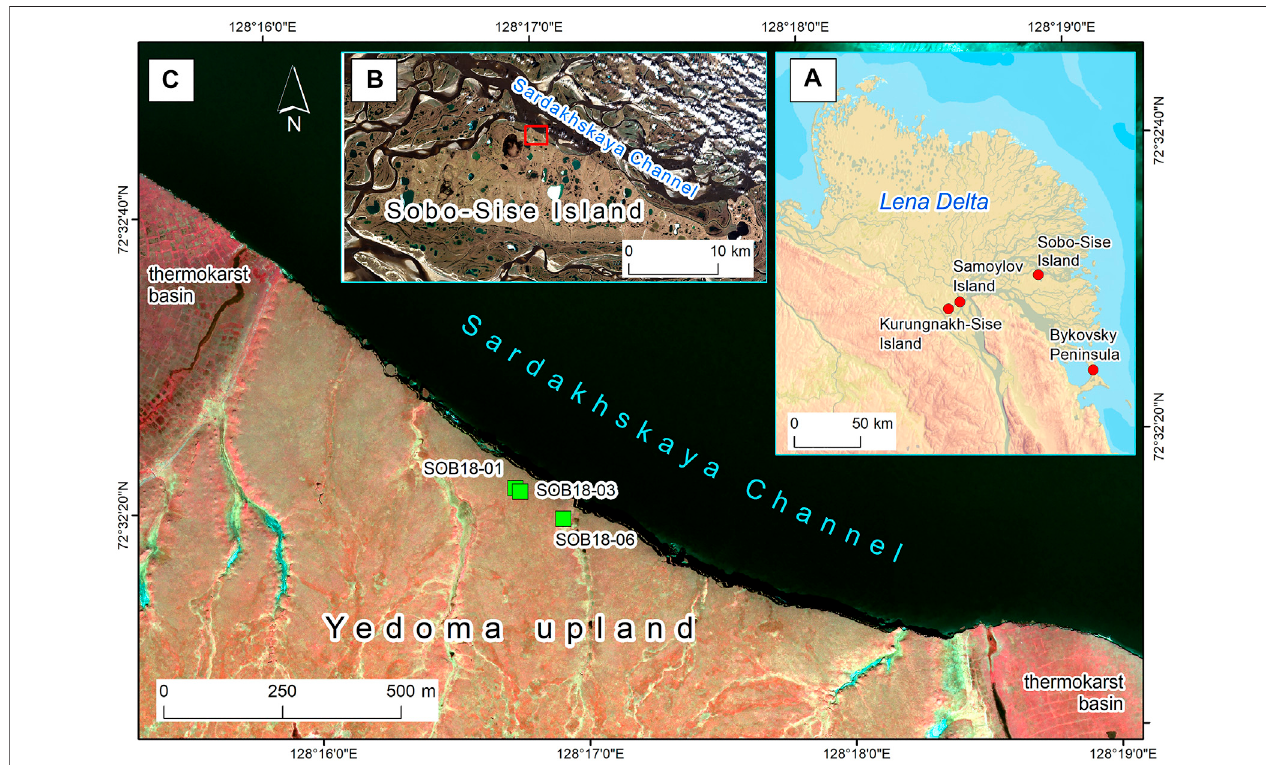
FIGURE 1 | Study area in north-eastern Siberia showing (A) the Lena Delta with key locations, (B) Sobo-Sise Island (image based on Sentinel-2A scene, June 27, 2018) and (C) the Sobo-Sise Yedoma cliff facing the Sardakhskaya Channel (image based on GeoEye-1 scene, July 08, 2014) with positions of the sampled sediment pro fi les SOB18-01, SOB18-03 and SOB18-06. Panel (A) is based on the semitransparent layer of the ESRI ArcGIS Living Atlas of the World (World Topo Base, 2021) with underlying bathymetry of (IBCAO grid, 2021).